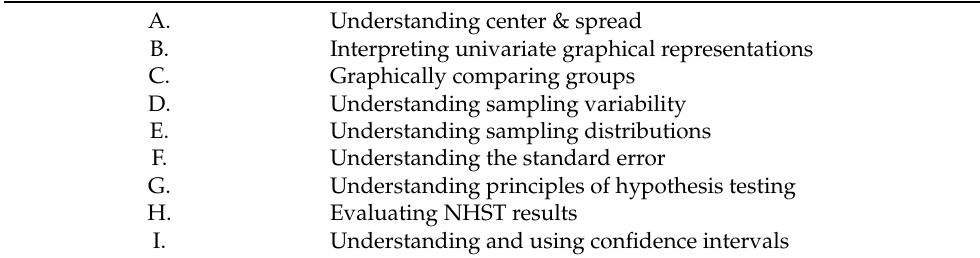
Table 1. The nine identified